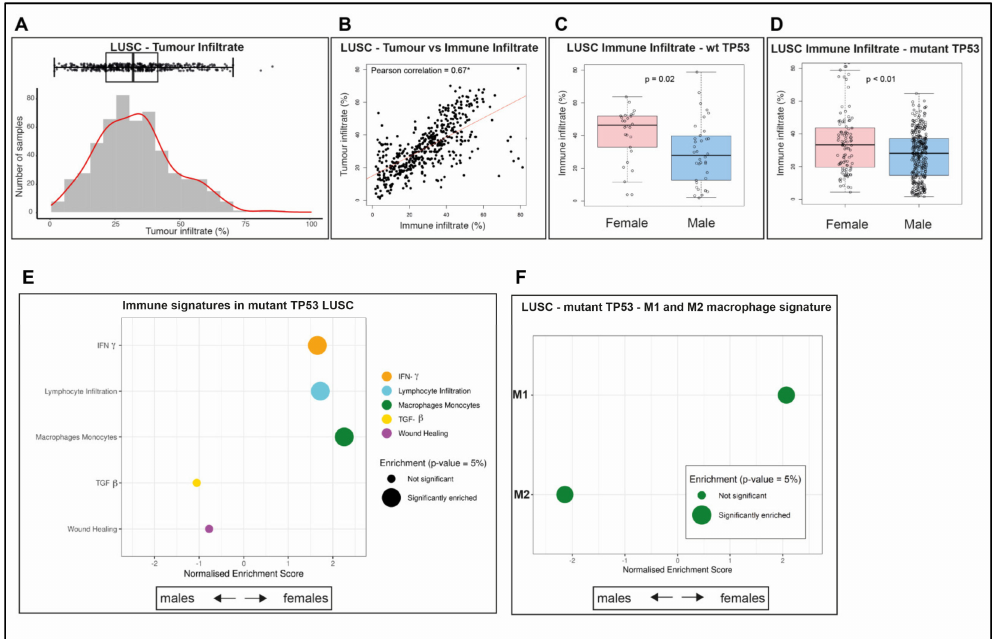
Figure 6. LUSC tumor infiltrate has a distinct immune content from LUAD. ( A ) Proportion of tumor infiltrate in each TCGA LUSC sample. ( B ) Correlation between the proportion of tumor infiltrate and immune infiltrate in these samples. A Pearson correlation coe ffi cient with the symbol * indicates the correlation is significantly di ff erent from 0, using the Spearman’s test of significance ( p -value < 0.05). Proportion of immune infiltrate for females compared with males in LUSC samples with either ( C ) wt TP53 , p- value = 0.02, or ( D ) mutant TP53 , p- value < 0.01, using analysis of variance (ANOVA) to measure significance ( p- value < 0.05). GSEA of di ff erentially expressed genes in LUSC females relative to males with mutant TP53 for ( E ) immune signatures ( F ) M1 and M2 macrophage signatures. Significantly enriched immune signatures ( p- value < 0.05) are denoted by a large